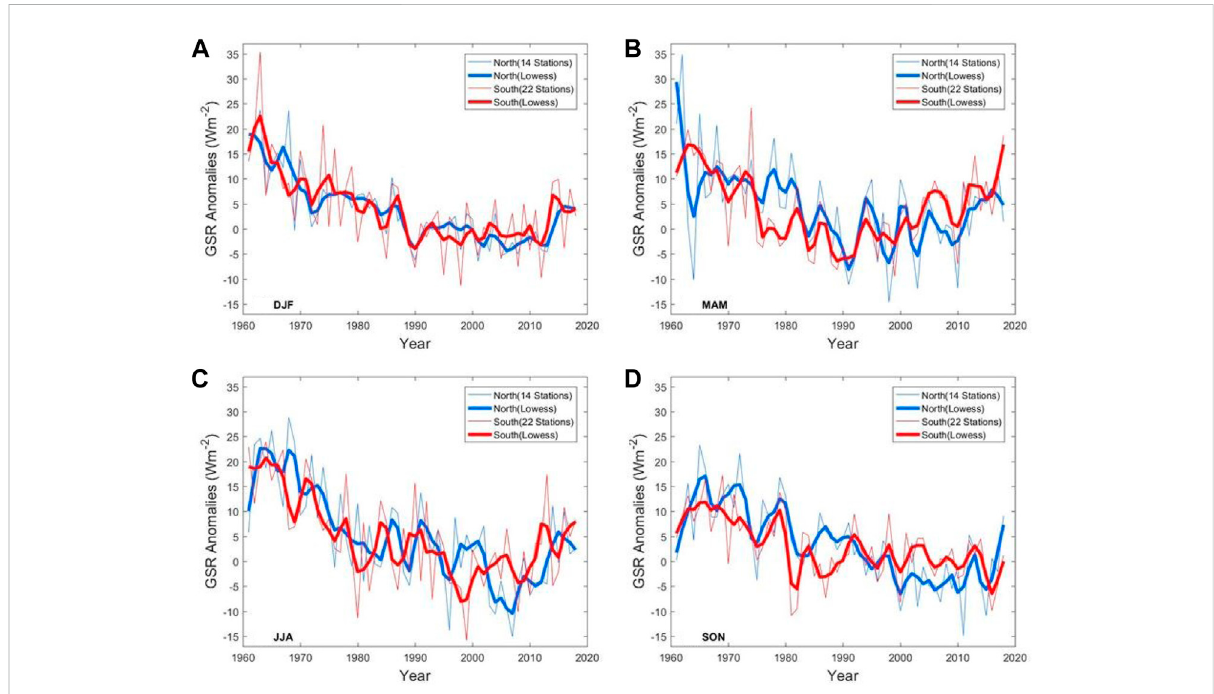
FIGURE 5 Time series of the area-weighted average GSR anomalies based on 14 stations in northern China (blue) and 22 stations in southern China (red) during (A) winter(DJF), (B) spring(MAM), (C) summer(JJA),and (D) autumn(SON)fortheperiod1961 – 2018.Originaldata(thinline)aresmoothedby the lowess fi lter (local regression using weighted linear least squares and a 1st-degree polynomial model) (thick